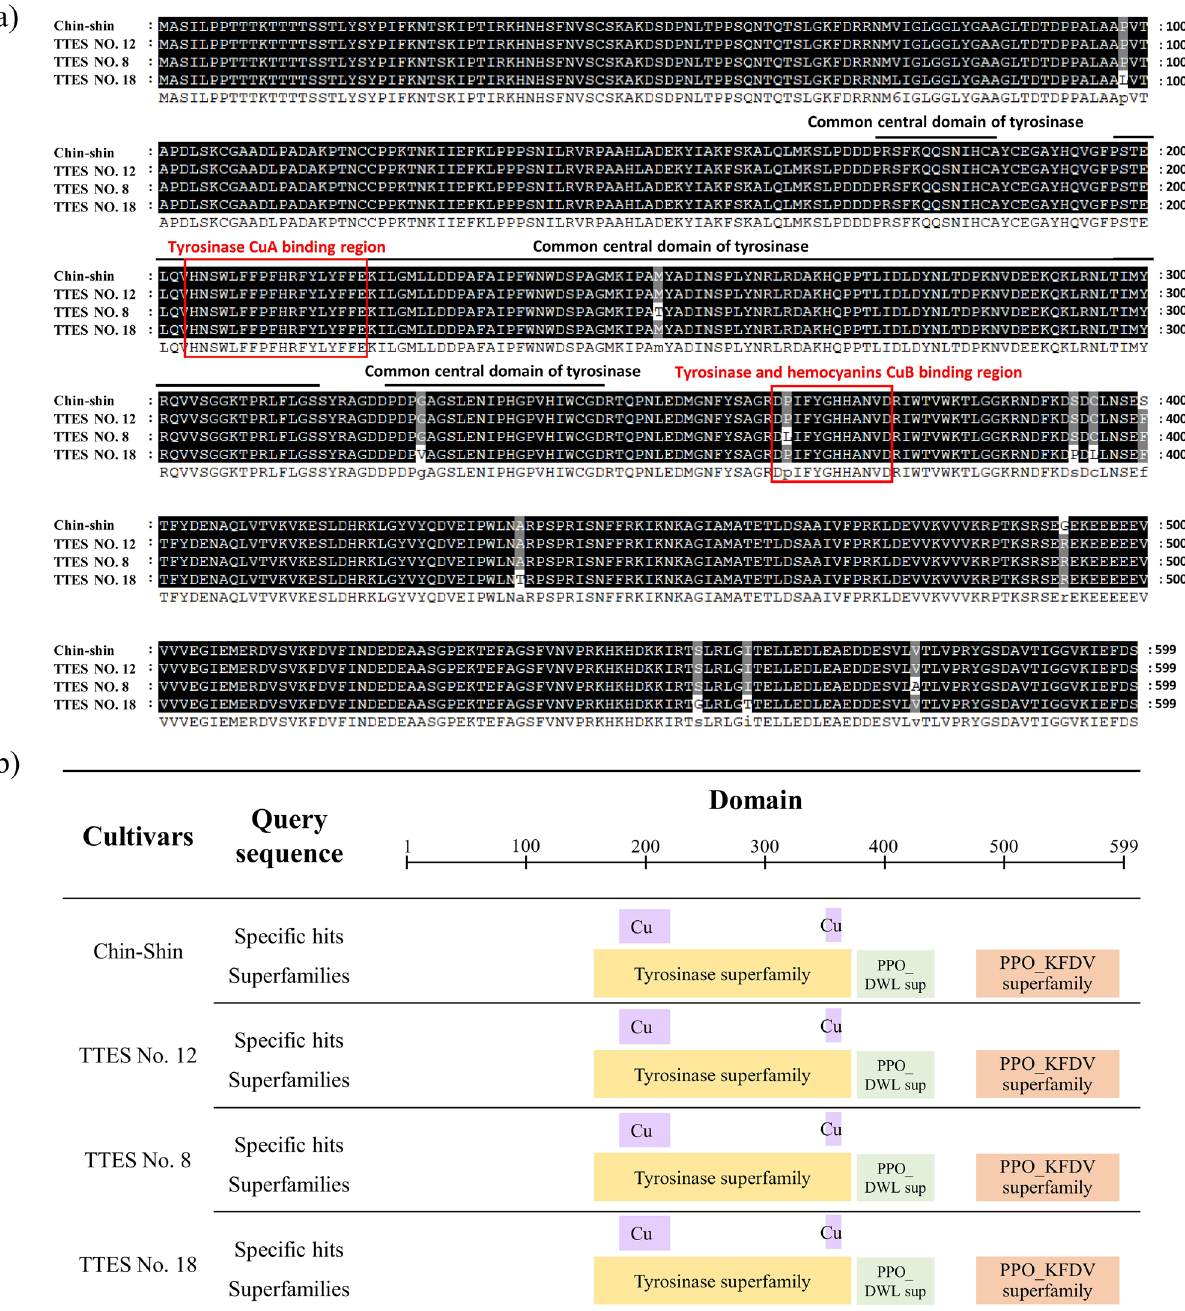
8, and TTES No. 18. The results indicated that although CsPPO transcript levels varied among the cultivars, the levels did not markedly differ between the small- and large-leaf cultivars (Fig. 2b,e).